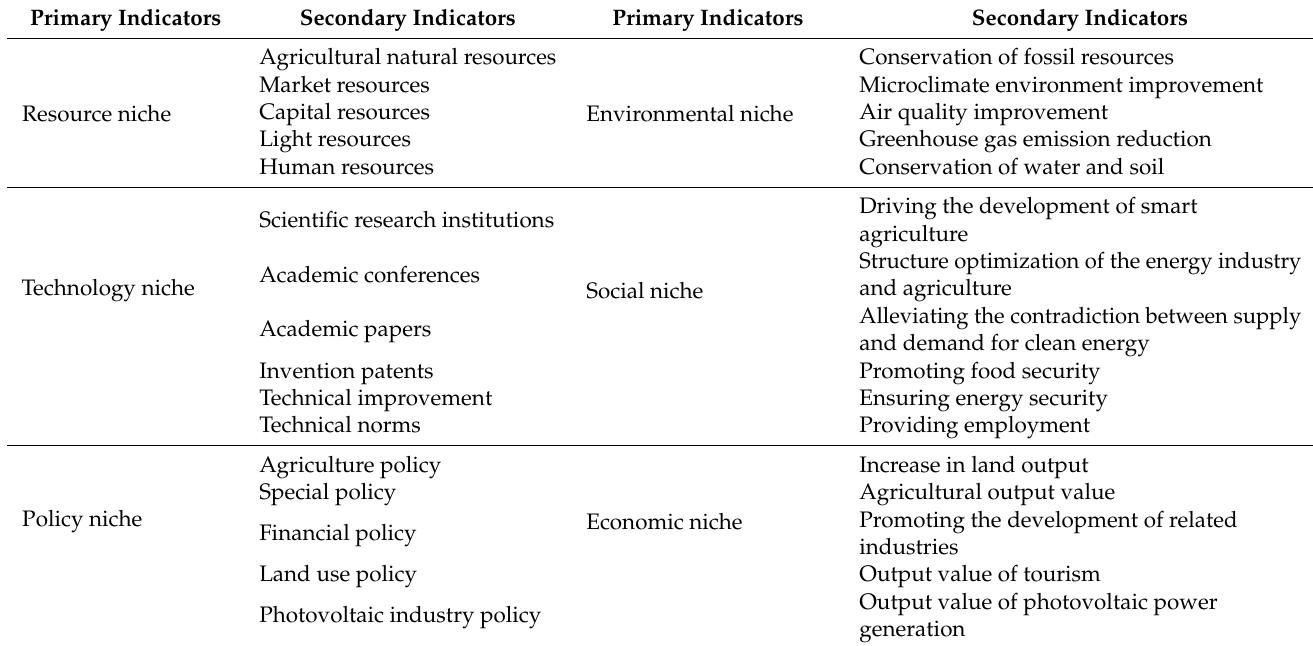
Table 1. Preliminary niche evaluation index system of photovoltaic